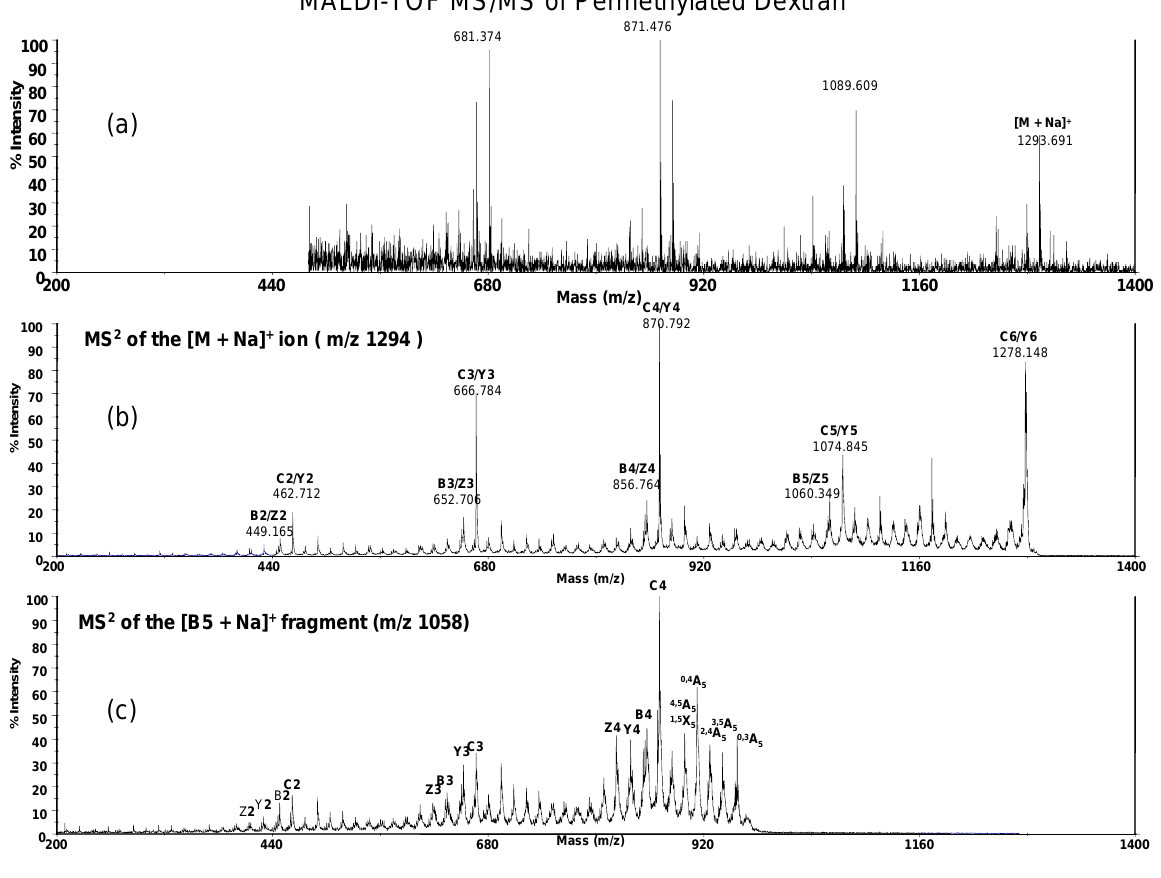
Figure 7. MALDI-TOF MS/MS of permethylated dextran glucans. The hexasaccharide ion ( m/z = 1293.8, [M + Na] + ) is shown in 7a. MS 2 at the hexasaccharide ion ([M + Na] + , m/z = 1293.8) is shown in 7b and MS 2 at the B sodiated fragment ion ( m/z = 1058.8) is 5 ~C region are 957.3 ( 0,3 A shown in 7c. The major cross-ring fragment ions at B 5 4 ( 3,5 A ), 925.9 ( 1,4 A ), 912.9 ( 0,4 A ) and 898.9 ( 4,5 A / 1,5 X ) 5 5 5 5 5